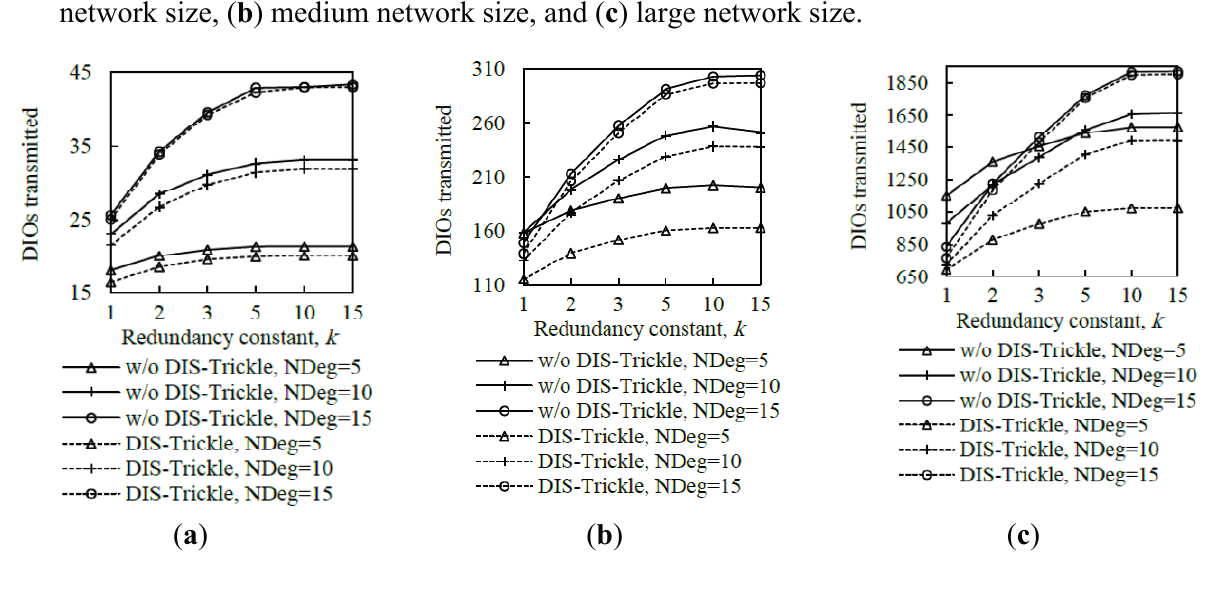
value is set to 8 ms: ( a ) Small min